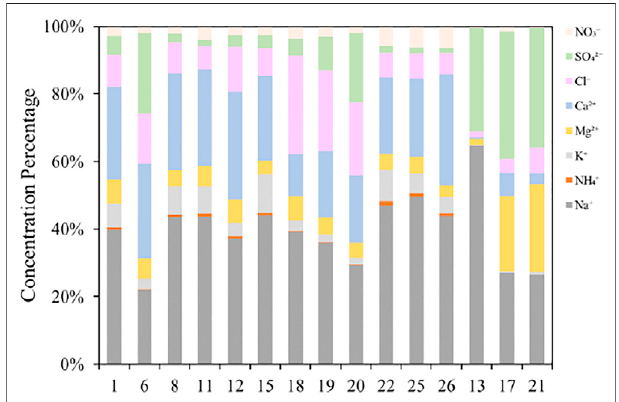
FIGURE 5 | Normalized ionic molar concentrations as a function of species for sand sample solutions (#1, #6, #8, #11, #12, #15, #18, #19, #20,